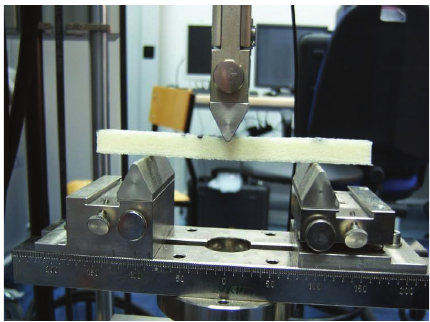
Figure 4: Way of mounting the sample while performing three- point bending